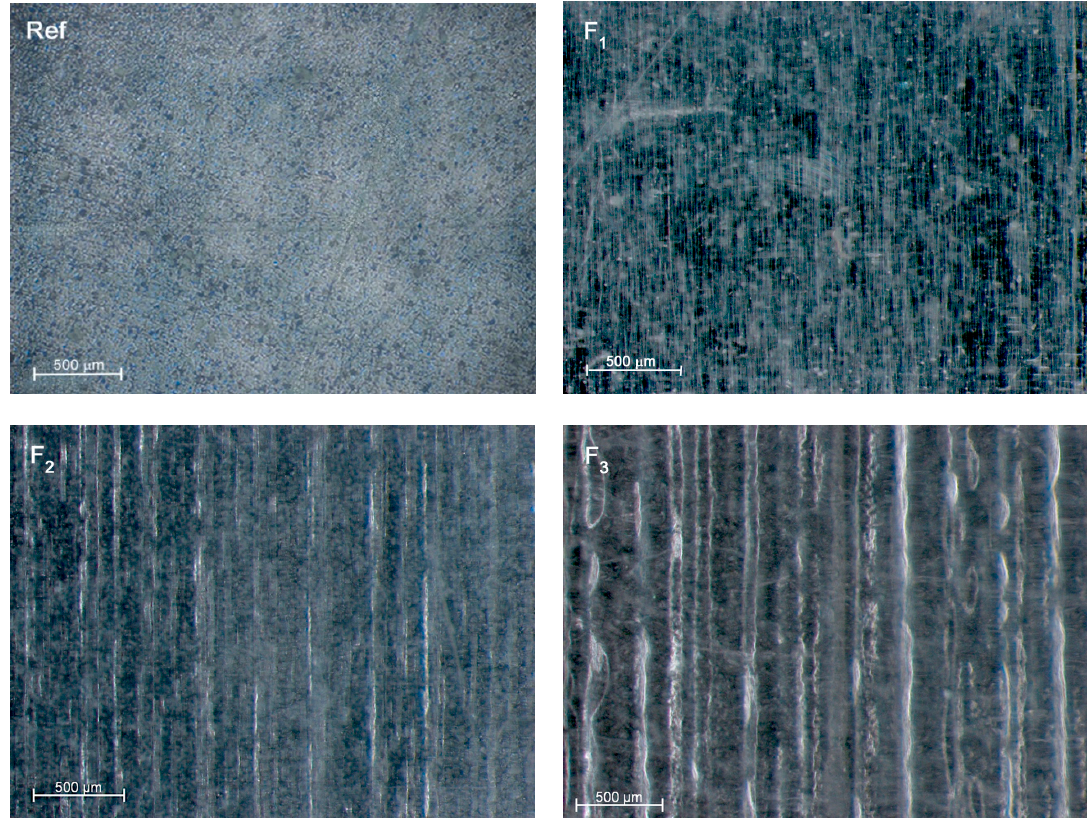
Figure 1. Microscopic images of the obtained surfaces (magnification 100×) recorded for reference material (Ref) and laser treated with accumulated fluences of 24 J / cm 2 (F 1 ), 48 J / cm 2 (F 2 ) and 71 J / cm 2 (F 3 ).